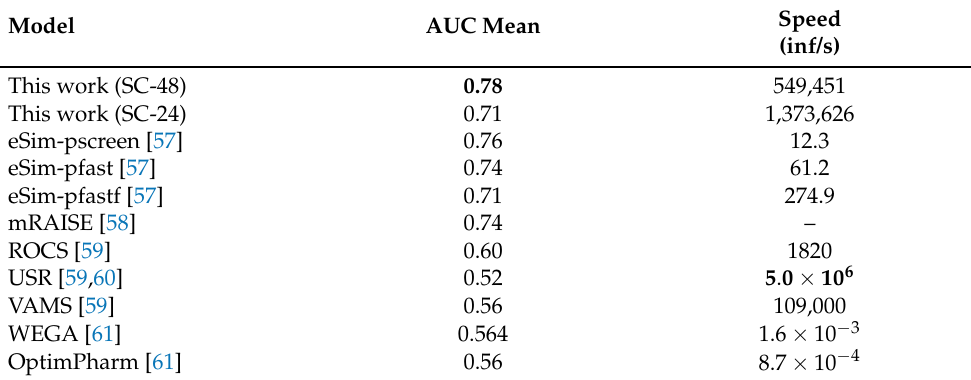
Table 2. Performance comparison between this work and different ligand-based methods taken from the literature.